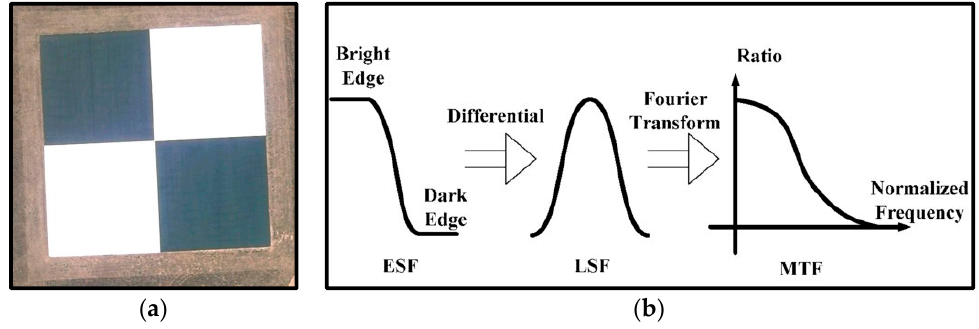
Figure 12. ( a ) Checkerboard edge target [179] ( b ) steps to estimate MTF [177] .